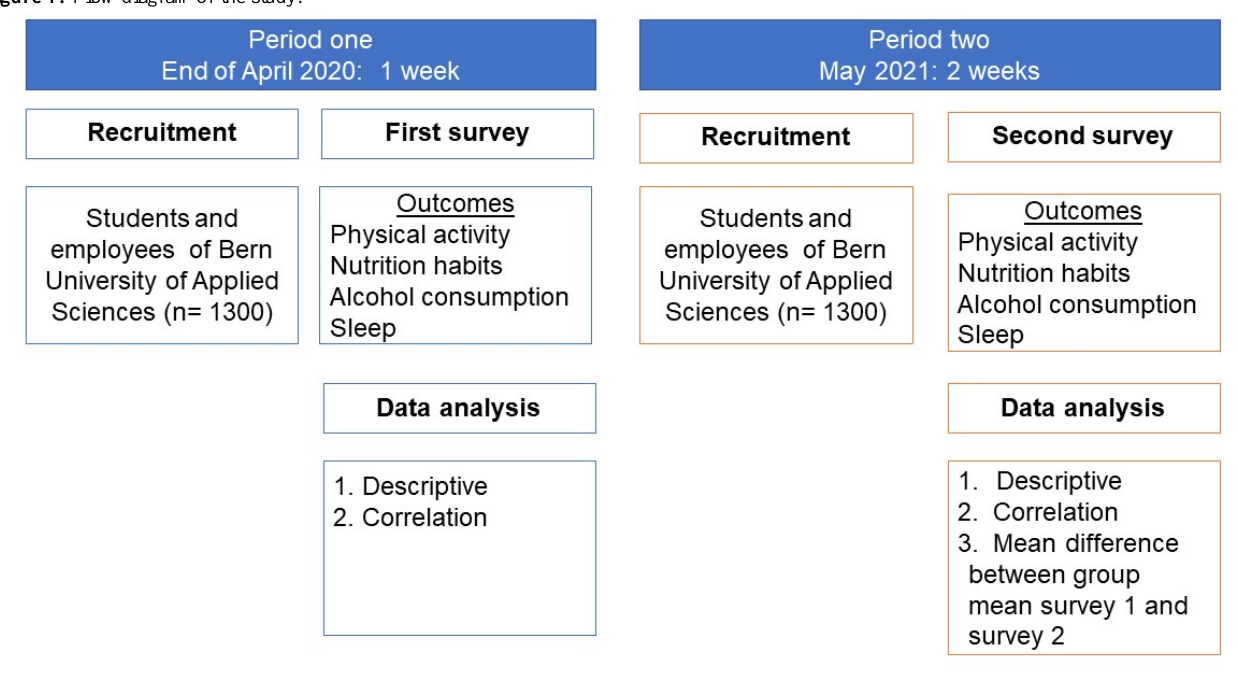
Figure 1. Flow diagram of the